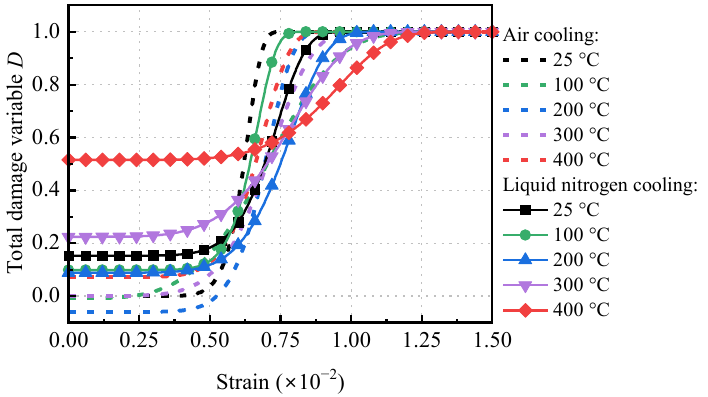
Figure 8. Total damage variables of heated granite after different cooling treatments.